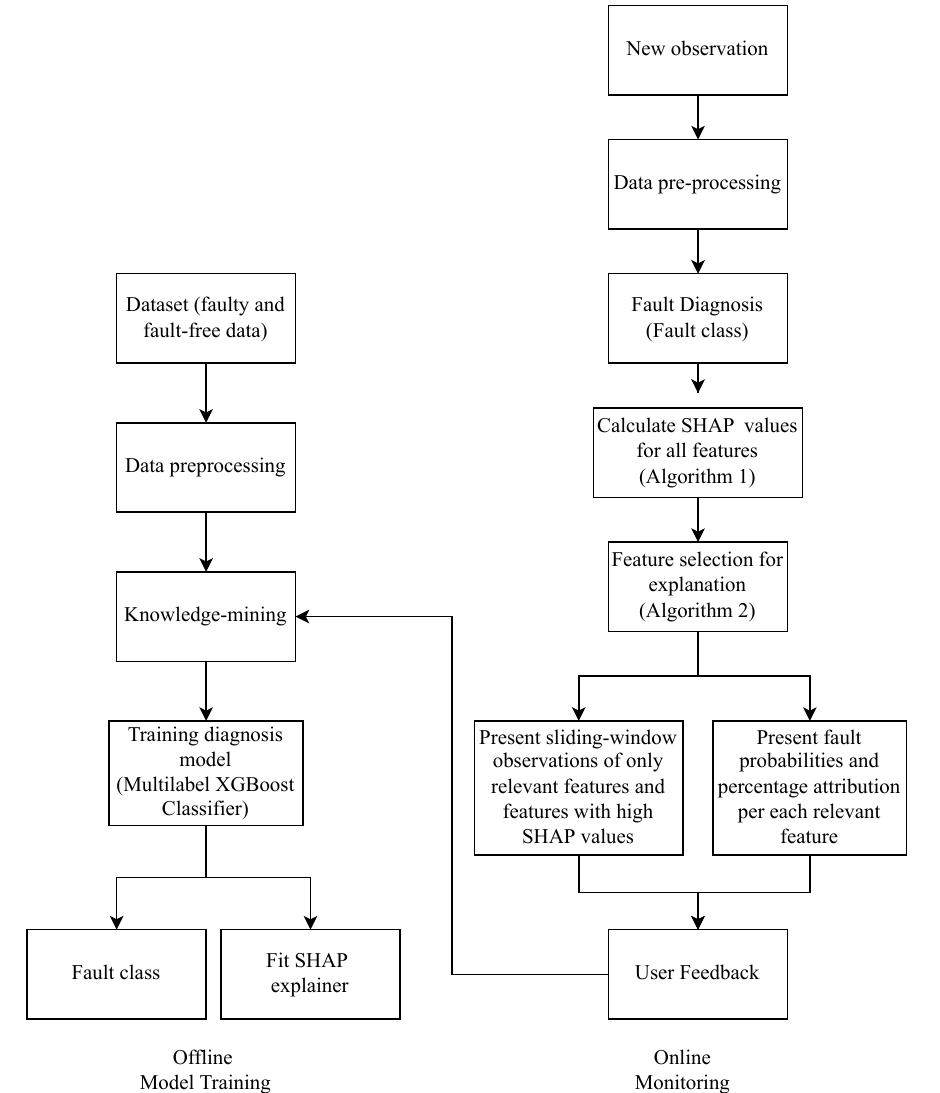
Figure 1. Proposed explainable fault detection and diagnosis pipeline. The left-hand side repre- sents the offline model training stage, while the right-hand side corresponds to the online fault monitoring stage.